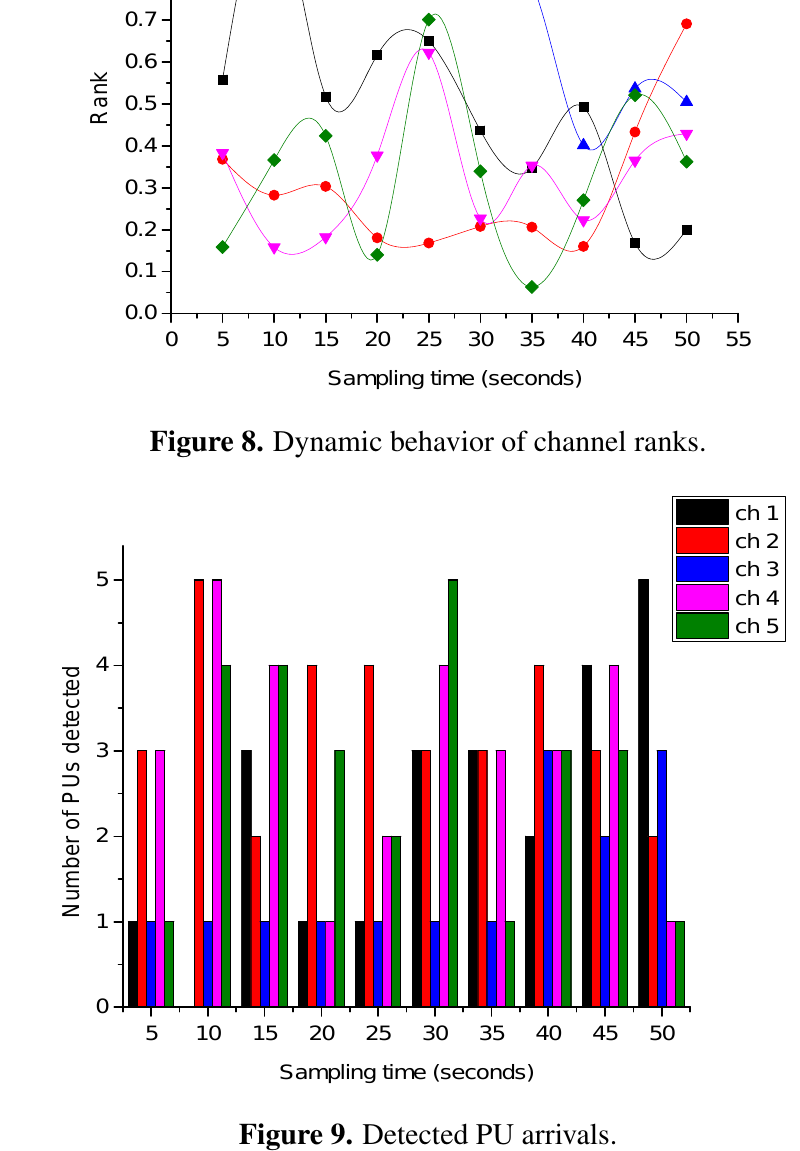
Figure 9. Detected PU